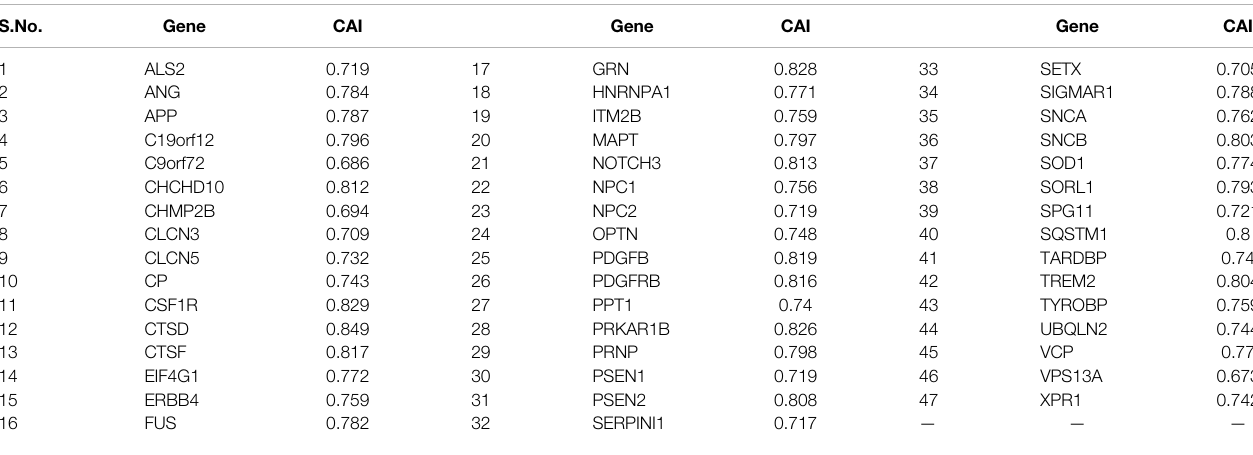
TABLE 3 | CAI values of the genes envisaged in the